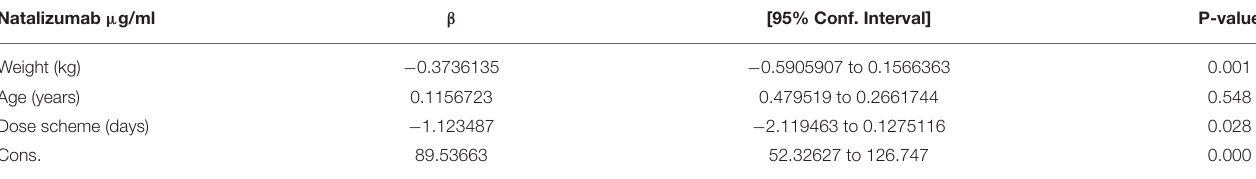
TABLE 2 | Multivariate analysis for drug serum levels and body weight (variables are considered as continuous). Natalizumab µ g/ml